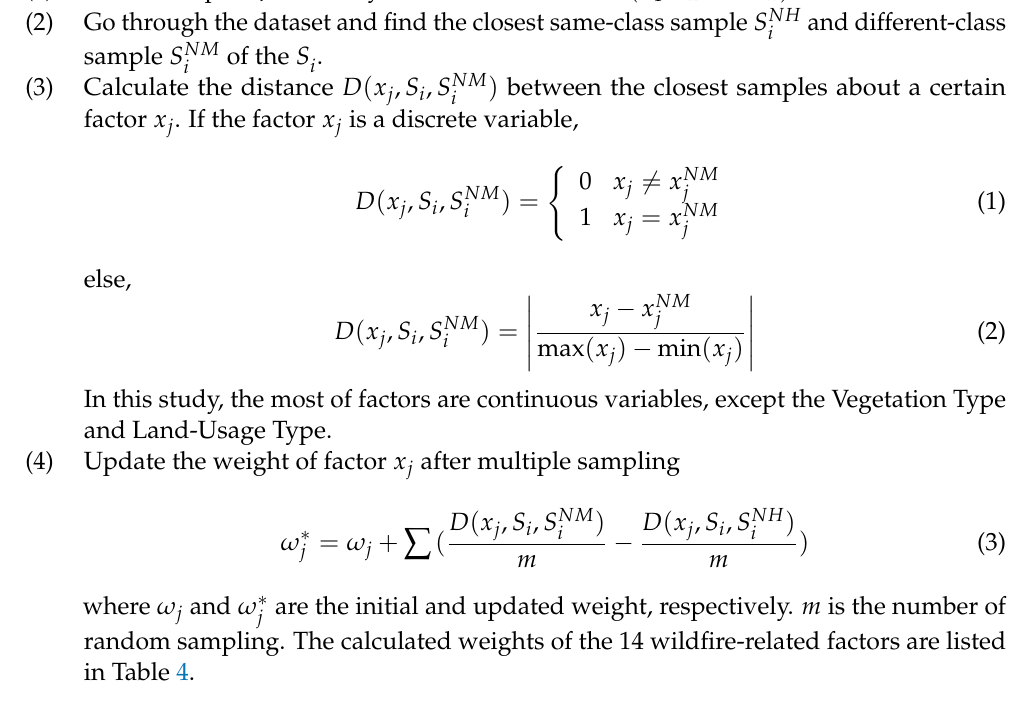
Table 4. Weights of wildfire-related factors based on the